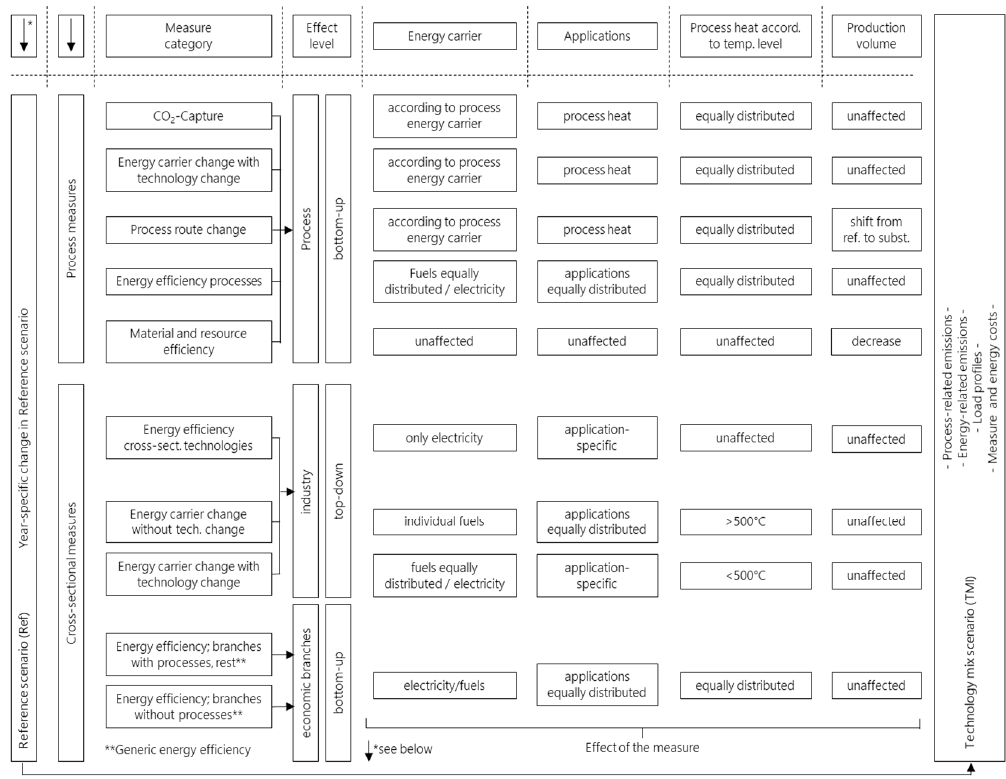
Figure 6. Functionality of the evaluation module in the technology mix module.